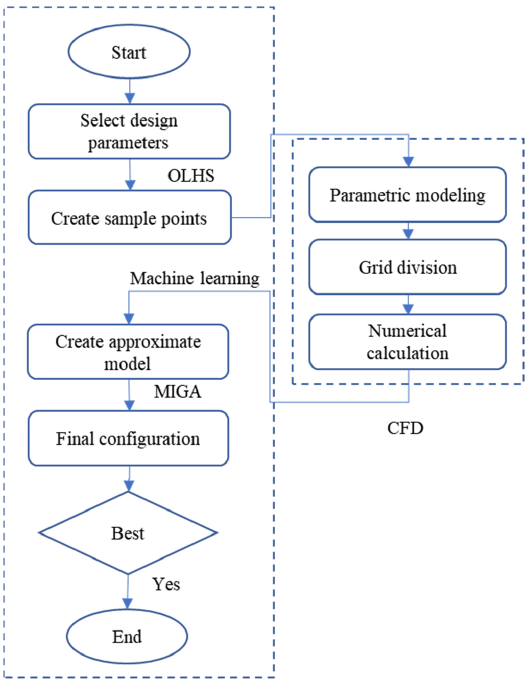
Figure 7. Optimization progress.